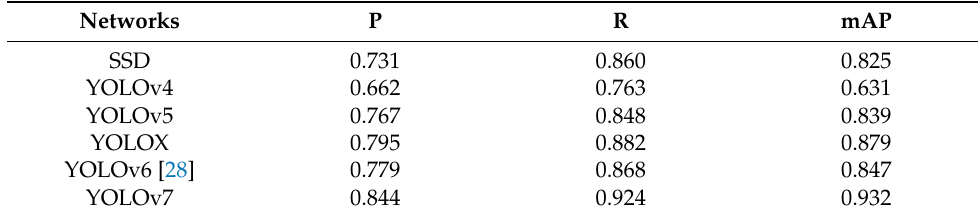
Table 3. Comparison results of YOLOv7 and other networks.